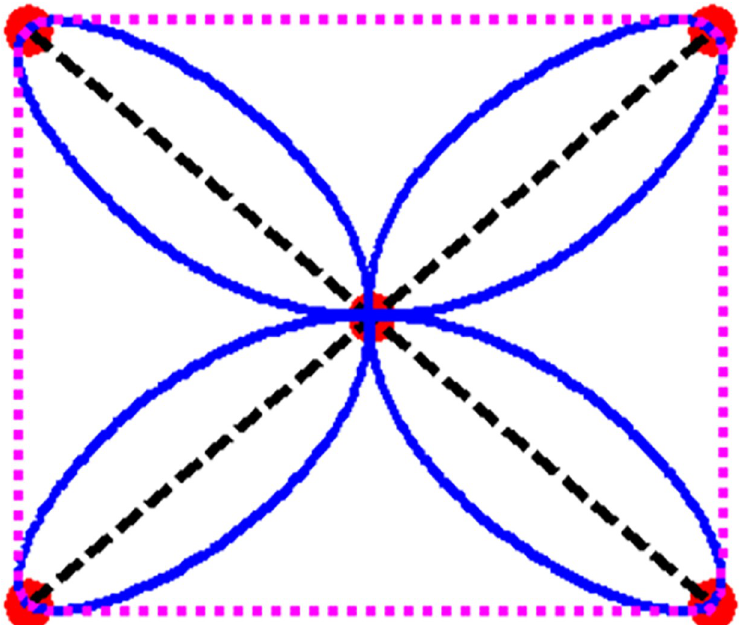
Fig 2. CHP using Flower data and its